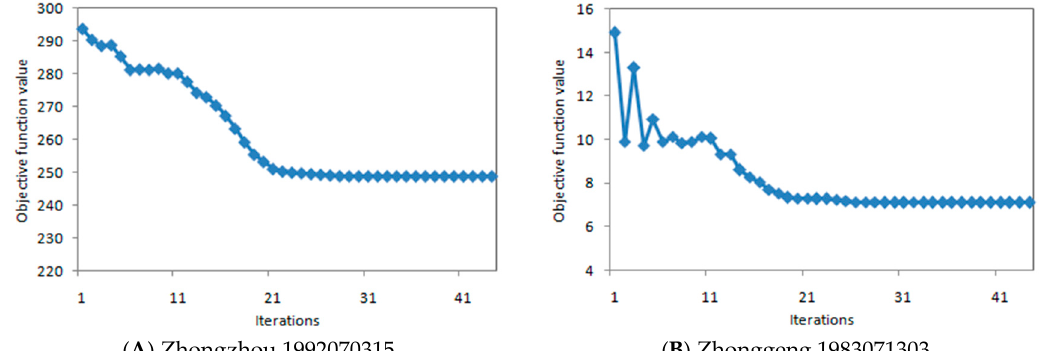
Figure 13. Objective function values in optimization process.